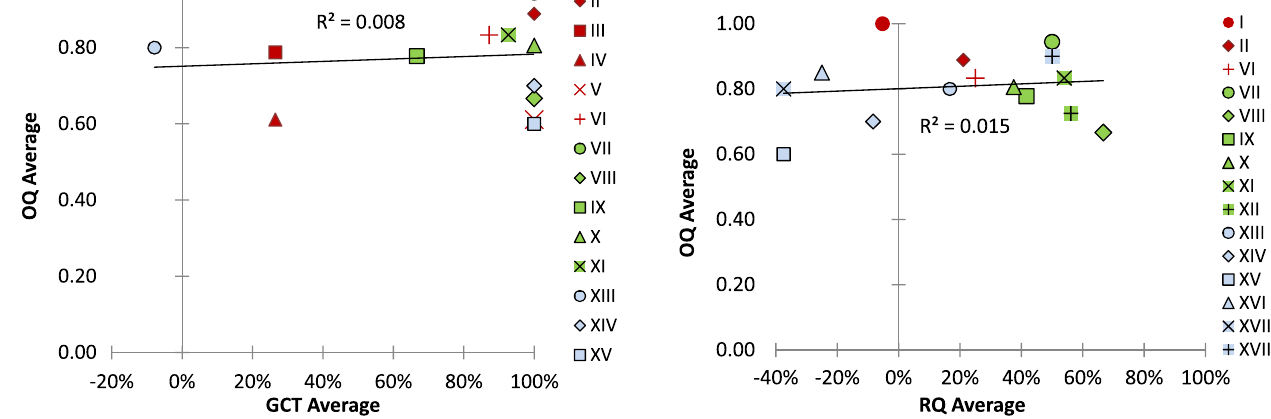
FIG. 8. Average scores on the individual comparison questions for the OQ vs the RQ, with linear regression and corresponding Pearson correlation coefficient ( R 2 ¼ 0 . 015 ). Error bars are not shown for clarity; the average standard error was (cid:2) 8 % for the RQ and (cid:2) 0 . 03 for the